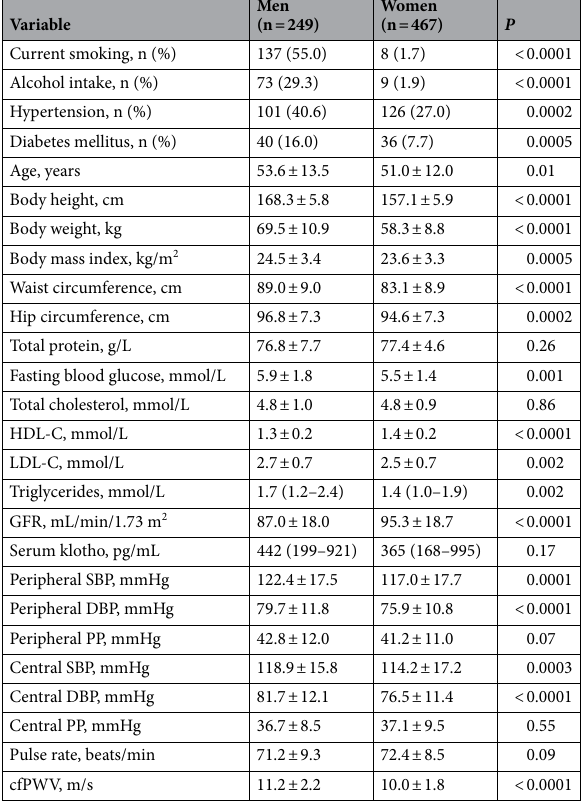
Table 1. Characteristics of the study population. Values are presented as means ± standard deviations, medians (interquartile ranges), or numbers (%). cfPWV carotid–femoral pulse wave velocity, DBP diastolic blood pressure, GFR glomerular filtration rate, HDL-C high-density lipoprotein cholesterol, LDL-C low-density lipoprotein cholesterol, PP pulse pressure, SBP systolic blood